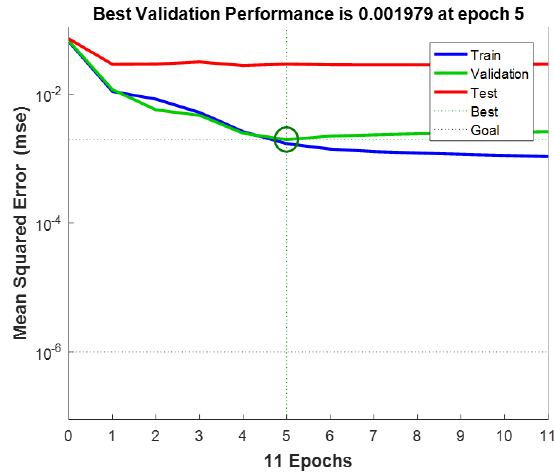
Figure 15. Mean square error graph.